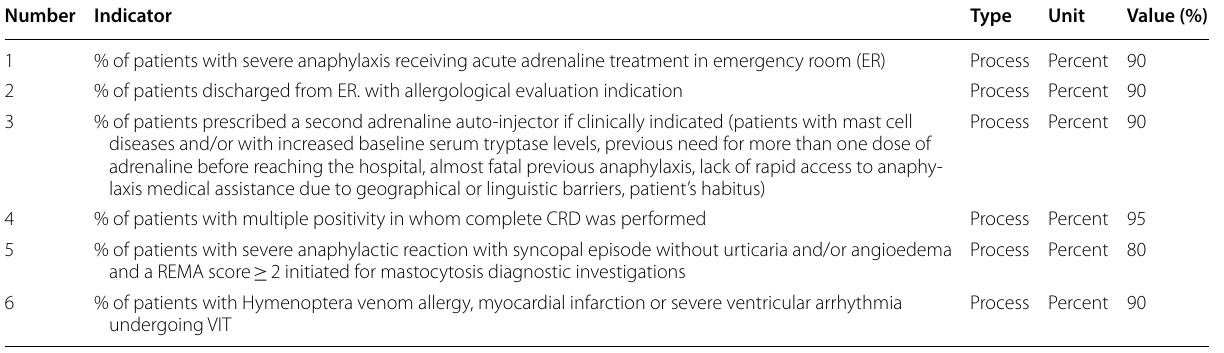
ET emergency treatment, D diagnosis, PT pharmacological therapy, VIT venom immunotherapy, M mastocytosis